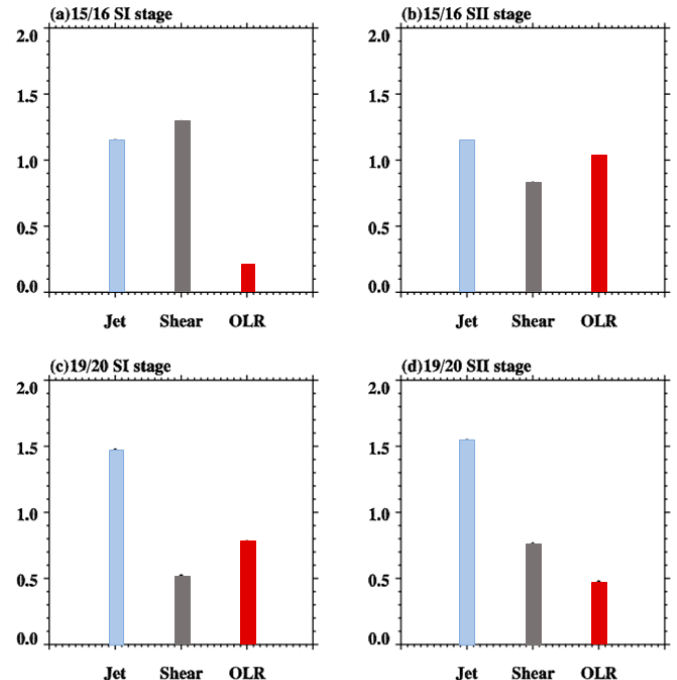
Figure 8. The variable importance in projection of the tropospheric jet (blue bars), stratospheric vertical shear (black bars), and tropospheric convection (red bars) during the ( a ) 2015/2016 SI stage, ( b ) 2015/2016 SII stage, ( c ) 2019/2020 SI stage, and ( d ) 2019/2020 SII stage.